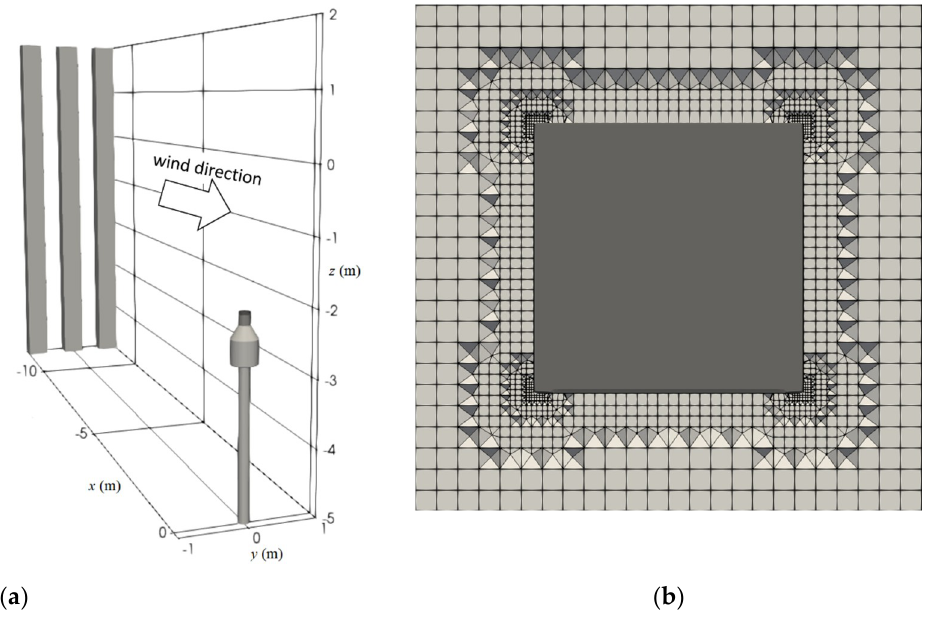
Figure 2. ( a ) Portion of the geometric setup with the three pillars positioned upstream of the gauge, and the wind direction indicated by the white arrow. ( b ) Horizontal section ( x , y plane) and gradual refinement of the computational mesh close to one sample pillar at a generic elevation.